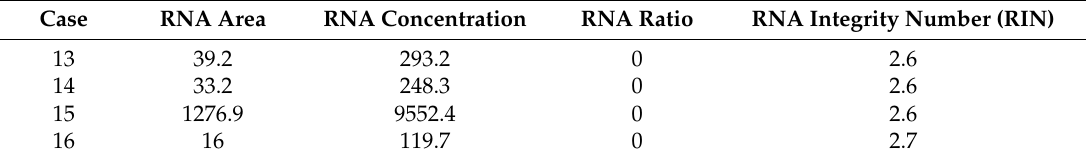
Table 3. Threshold cycle ( C t ) value of each miRNA and snoRNA in EVs extracted from the GJ of GC patients.